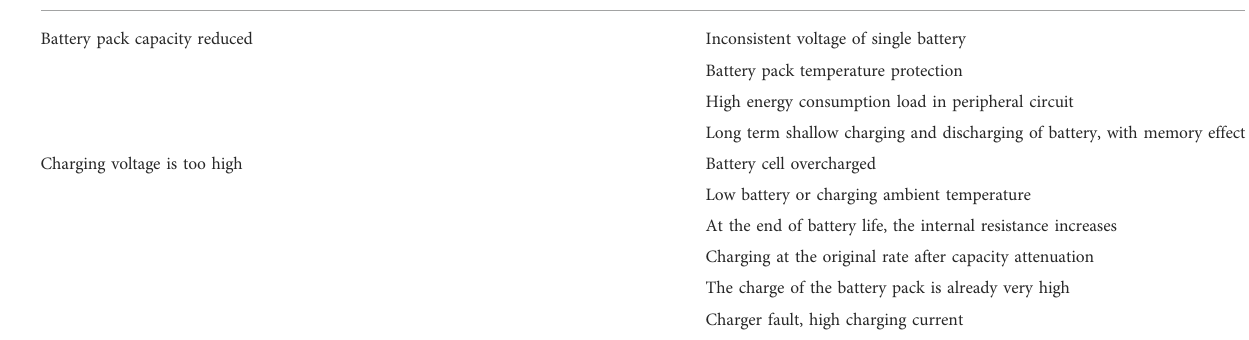
TABLE 1 Failure phenomena and causes of power battery. Fault